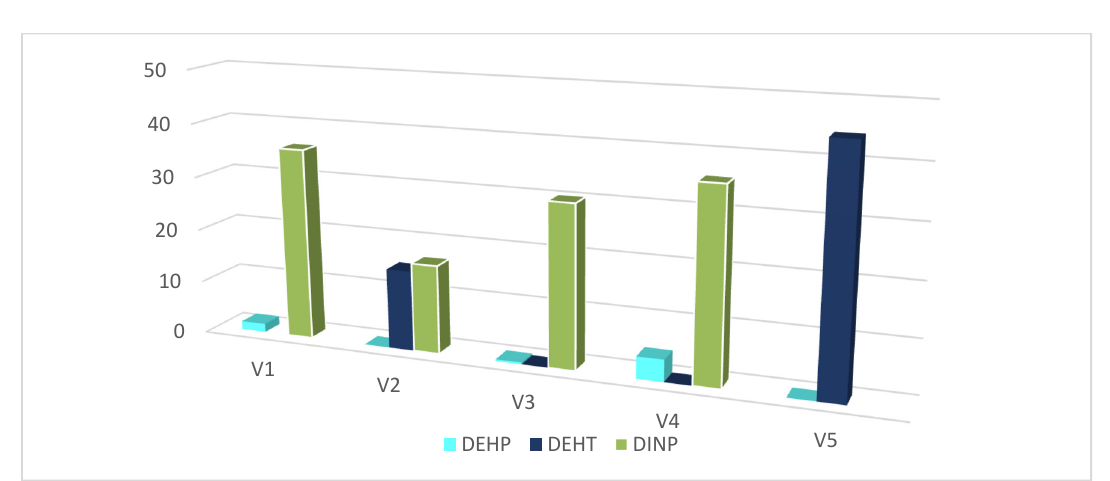
Figure 6. Contents of the majority plasticizers in the five vinyl gloves studied, determined by GC–MS.